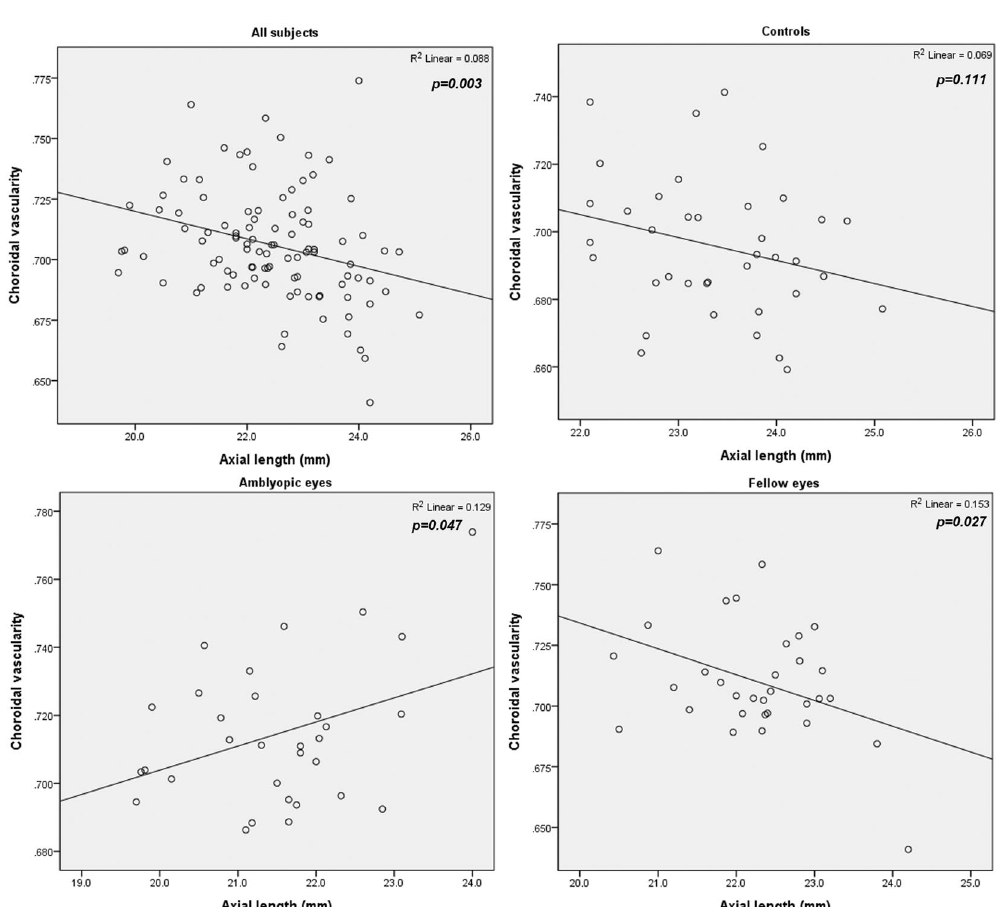
Figure 1. Correlation between axial length and choroidal vascularity. Averaged for all eyes in the study, choroidal vascularity (CV) had a negative correlation with axial length (AL) ( r = − 0.297, P = 0.003). In both groups, CV positively correlated with AL in amblyopic eyes and negatively correlated in fellow eyes (r = 0.360, P = 0.047; and r = − 0.391, P =